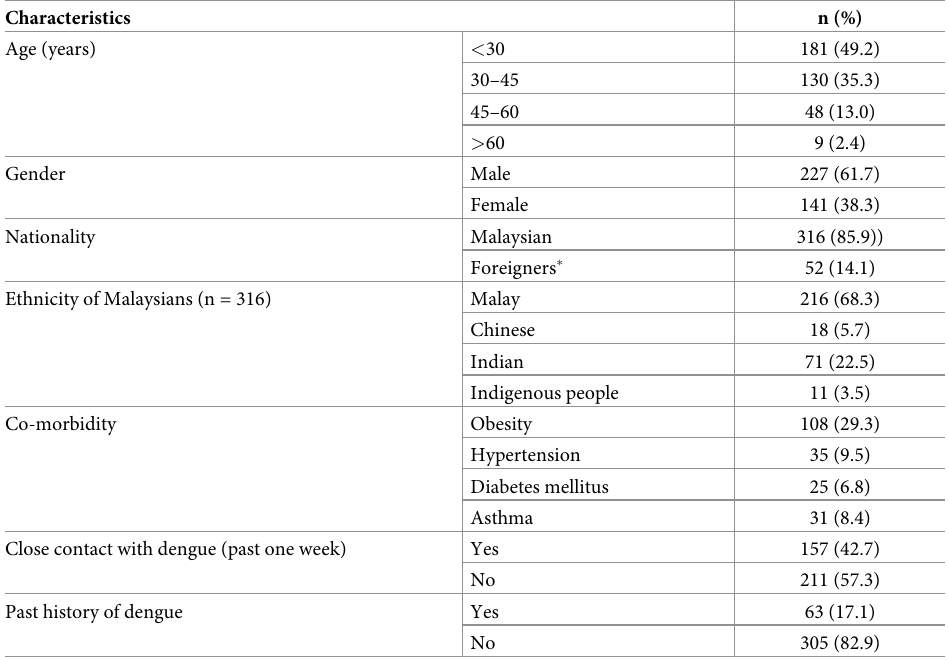
� Country of origin: Bangladesh (n = 24), China (n = 9), Nepal (n = 8), Pakistan (n = 5), Myanmar (n = 4), Indonesia (n = 1) and India (n =